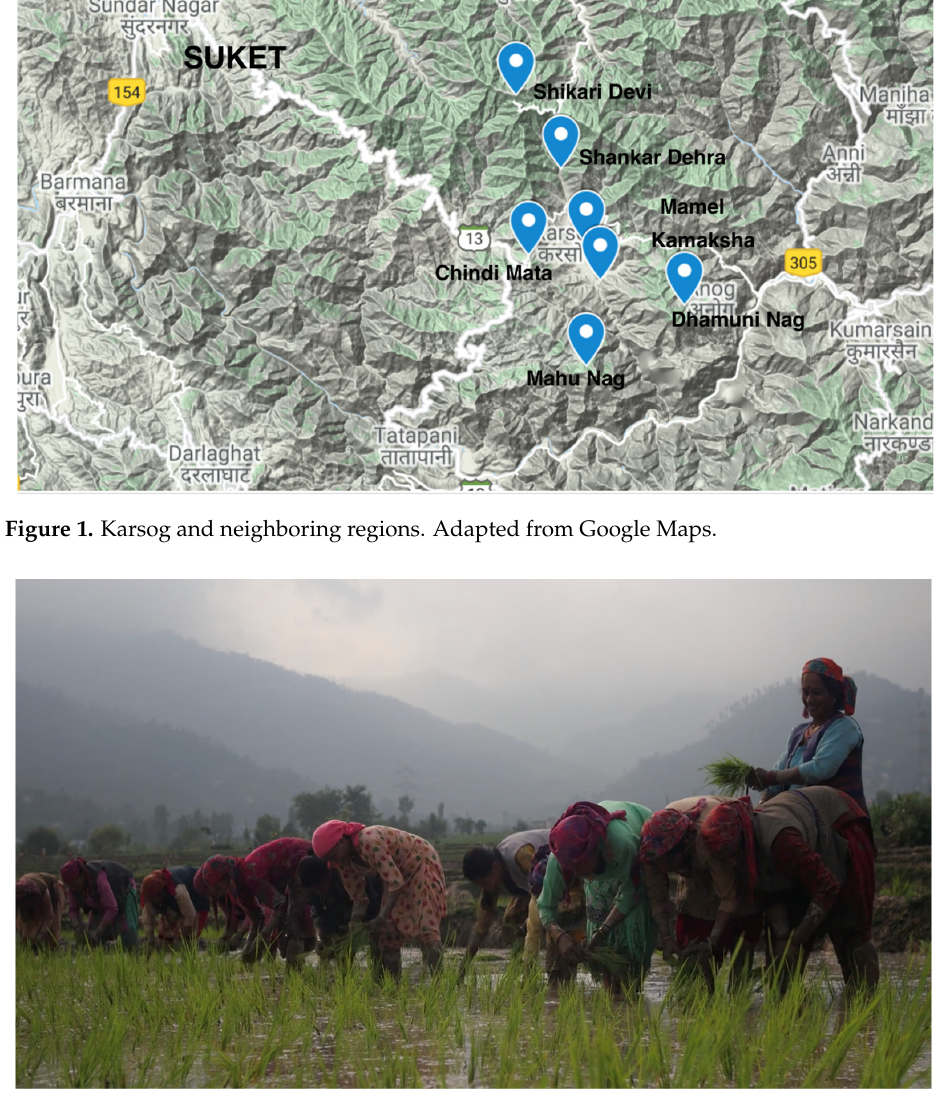
Figure 2. Rice planting in the Karsog Valley. Credit: Nadav Harel.